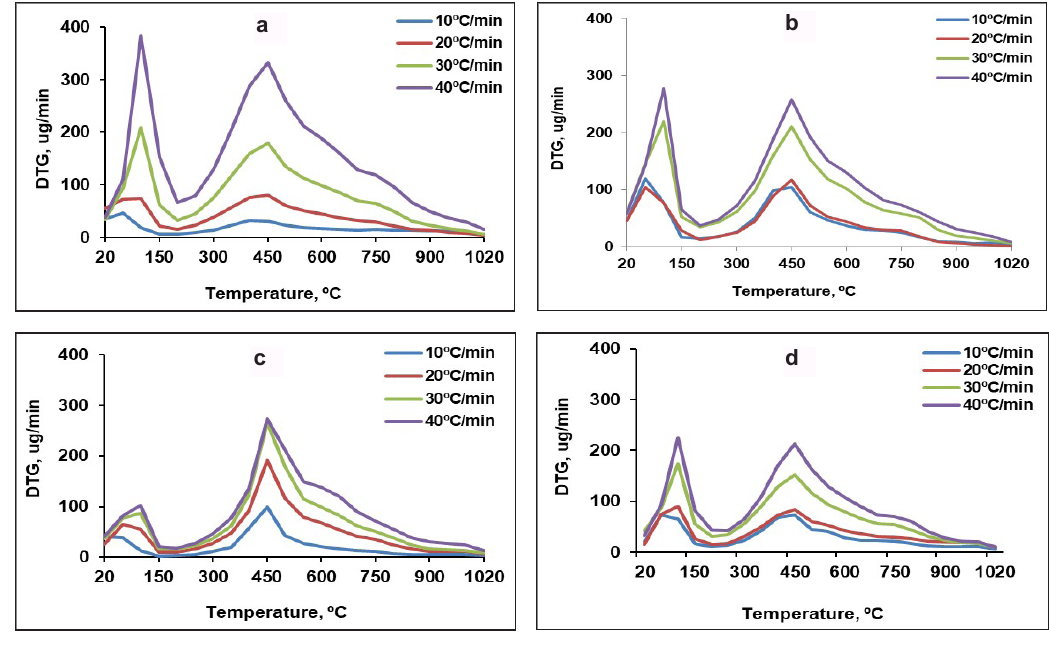
Fig. 2. DTG curves of coals